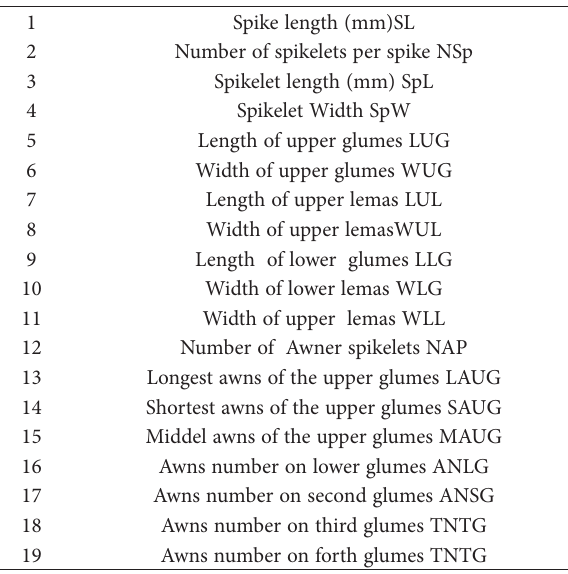
Table 2. Evaluated morphological characters in Ae. tauschii